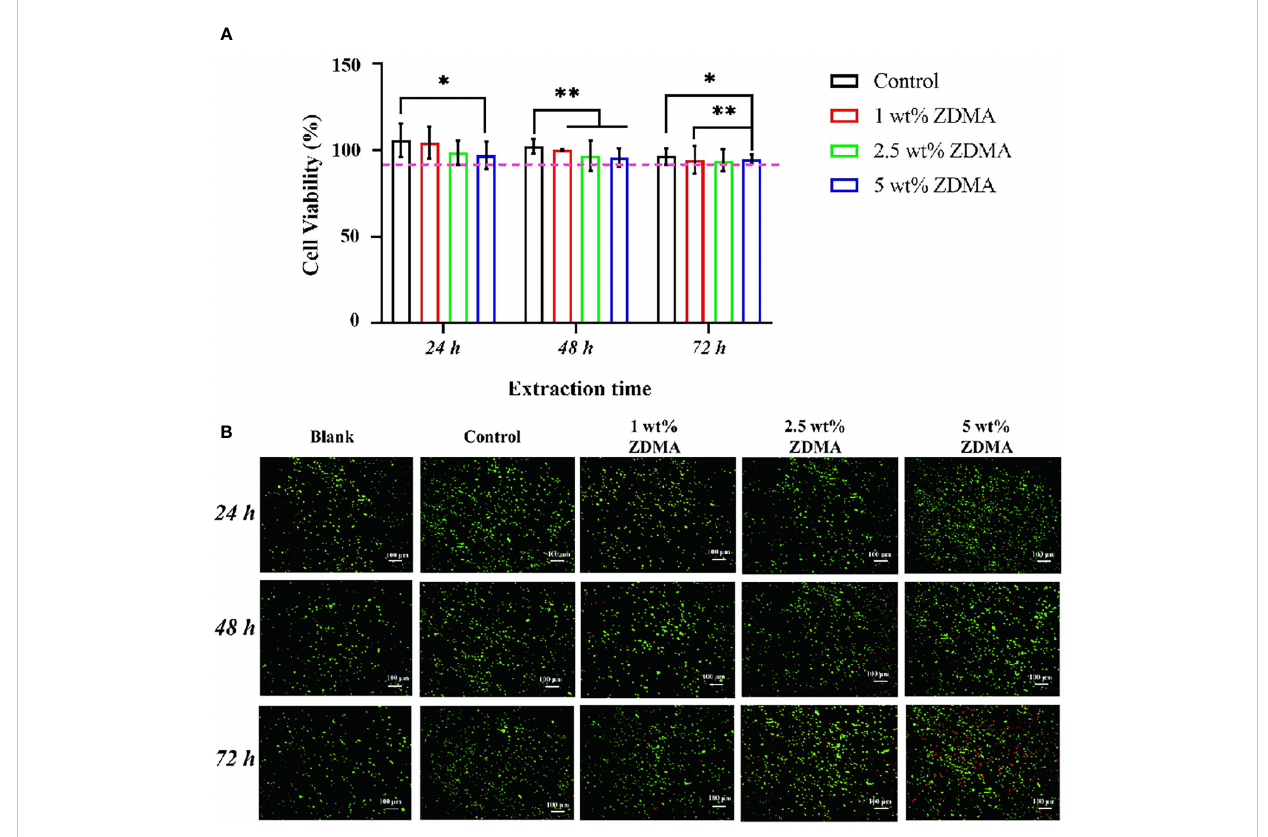
FIGURE 11 Cytotoxicity results of the extracts from each group. (A) The cytotoxicity of the extracts from each group determined by MTT assay (*p < 0.05, **p < 0.01). (B) Representative images of live/dead double staining of HGFs seeded with the extracts for each group and different extracting